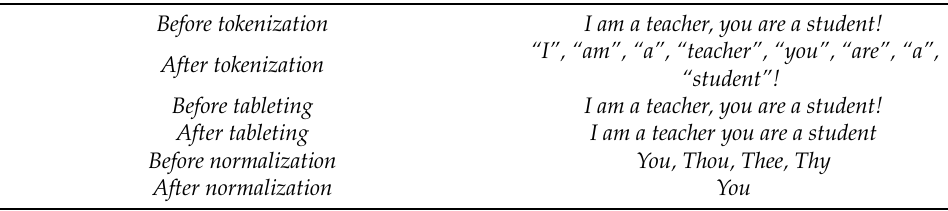
Table 1. Example of preprocessing results using